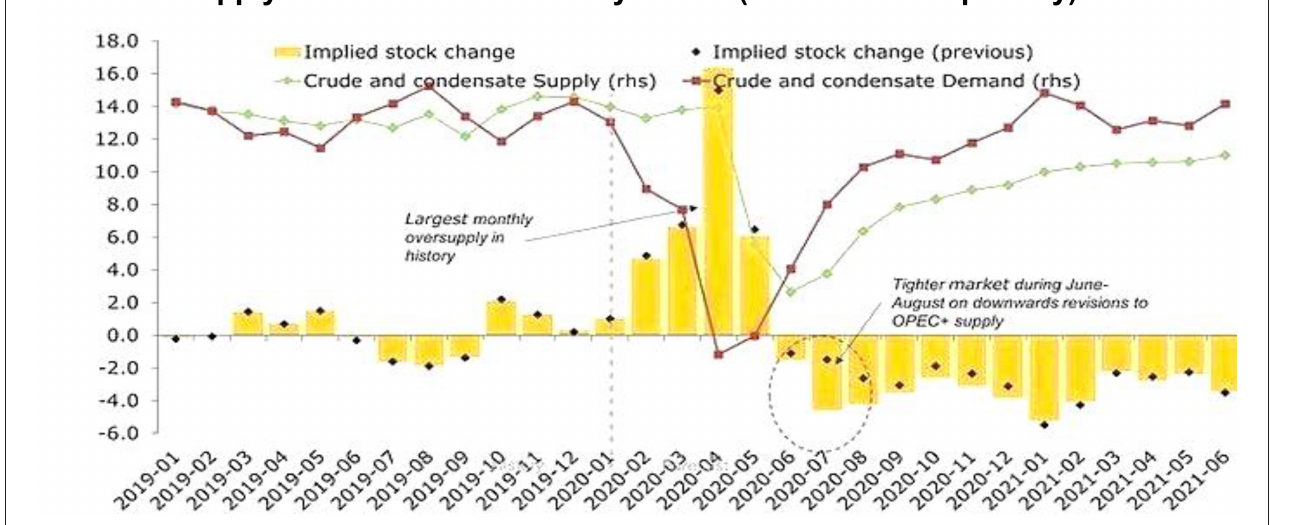
FIGURE 1 | Global oil supply and demand balance by month (Million barrels per day). Source: (4).